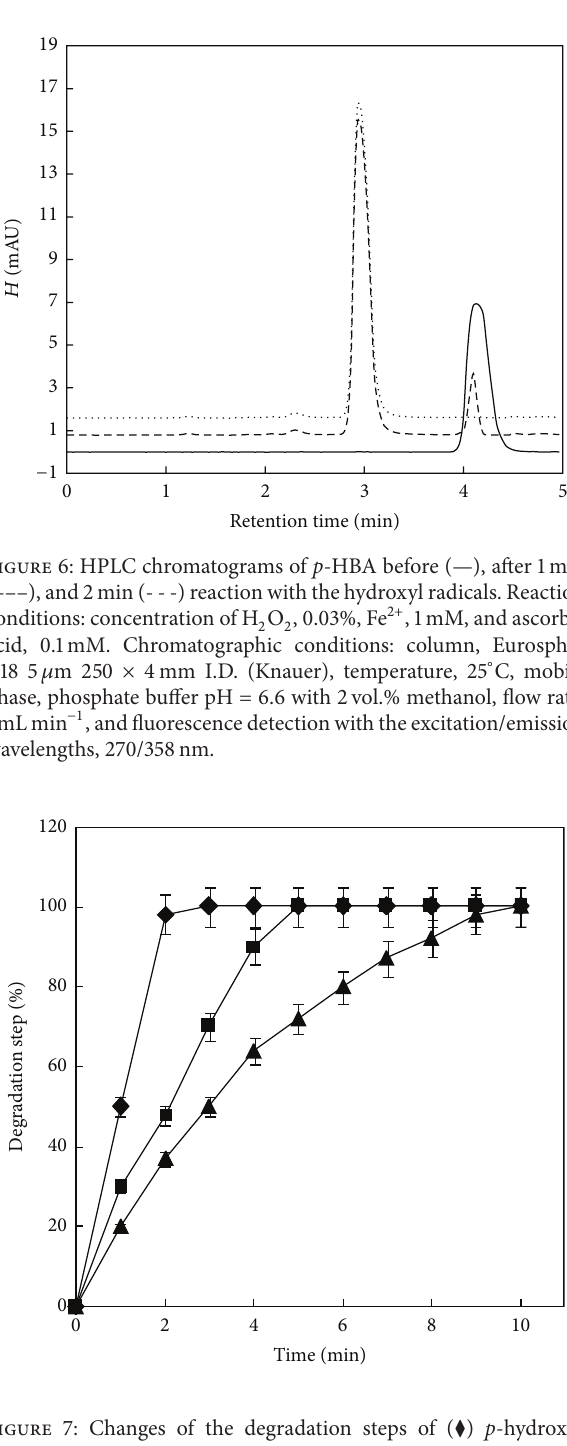
Figure 7: Changes of the degradation steps of ( ⧫ ) p -hydroxy- benzoic, ( ◼ ) sulfosalicylic, and ( 󳵳 ) p -aminobenzenesulphonic acids.